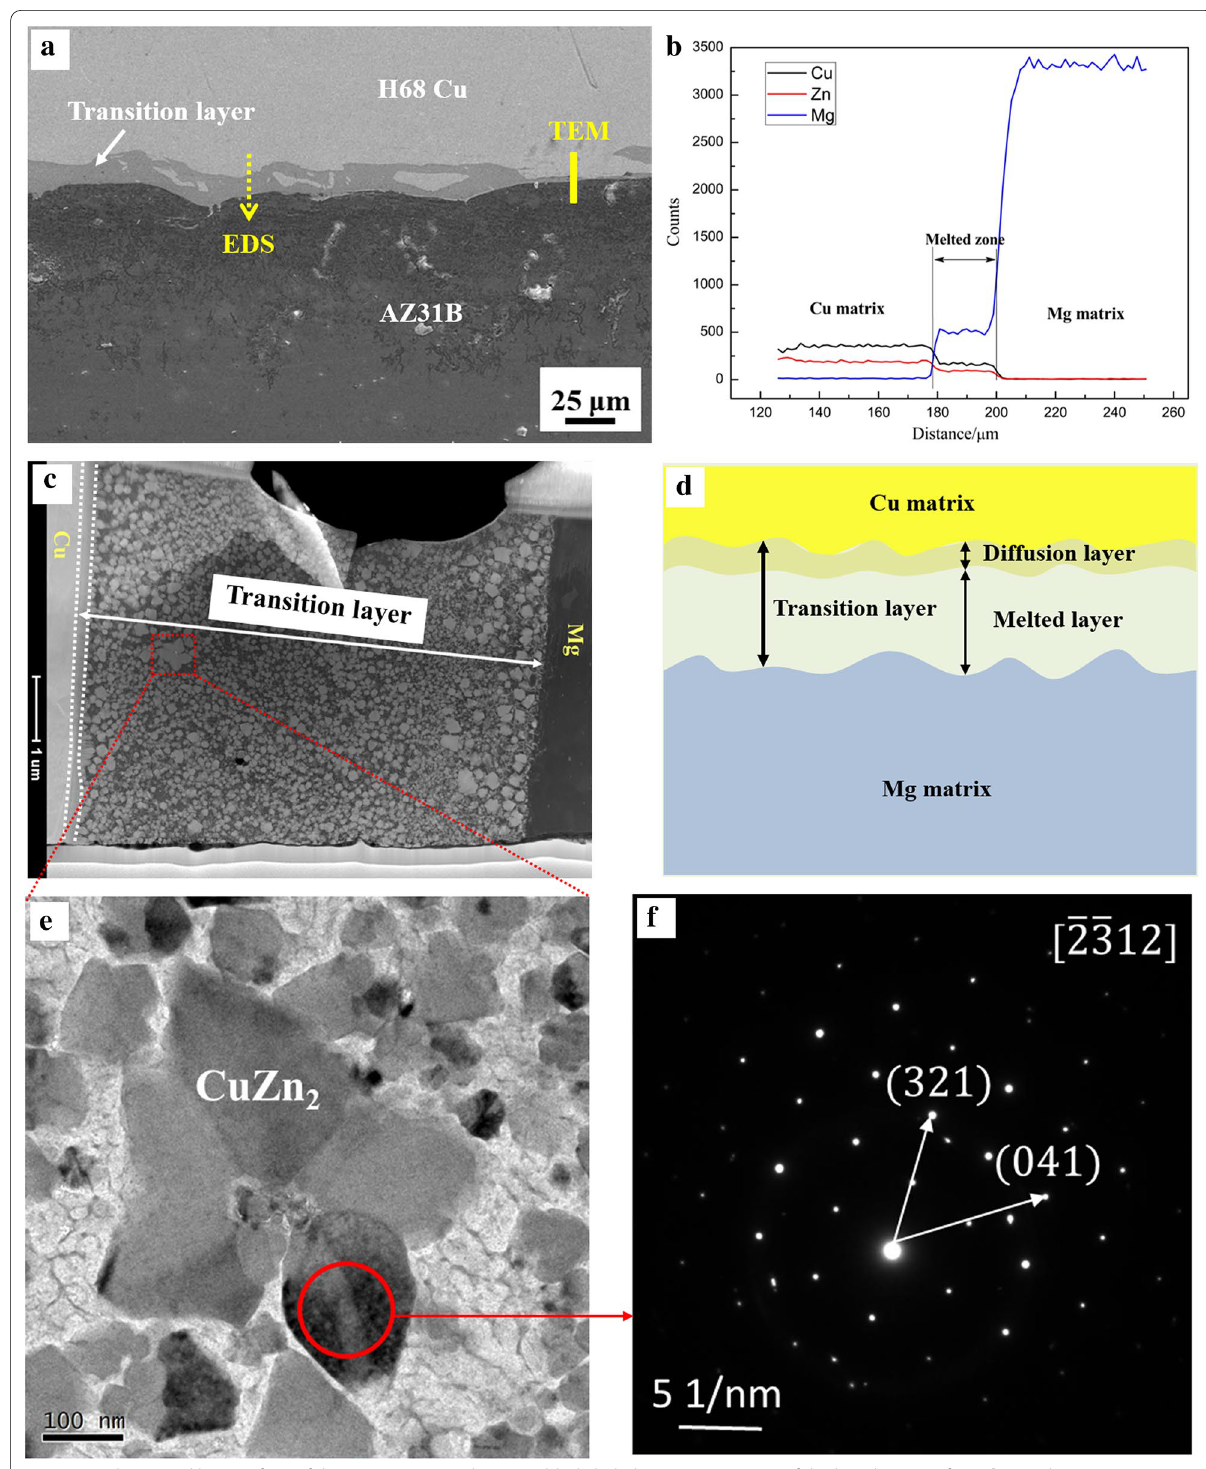
Figure 4 The wave-like interface of the H68/AZ31B explosive welded clad plate: ( a ) BSE image of the bonding interface; ( b ) EDS line scanning obtained perpendicular to the bonding interface; ( c ) TEM images at the transition layer; ( d ) Typical structures at the bonding interface; ( e ) Enlarged view of new phase zone (Red dashed box shown in ( c )); ( f ) Selected area electron diffraction pattern